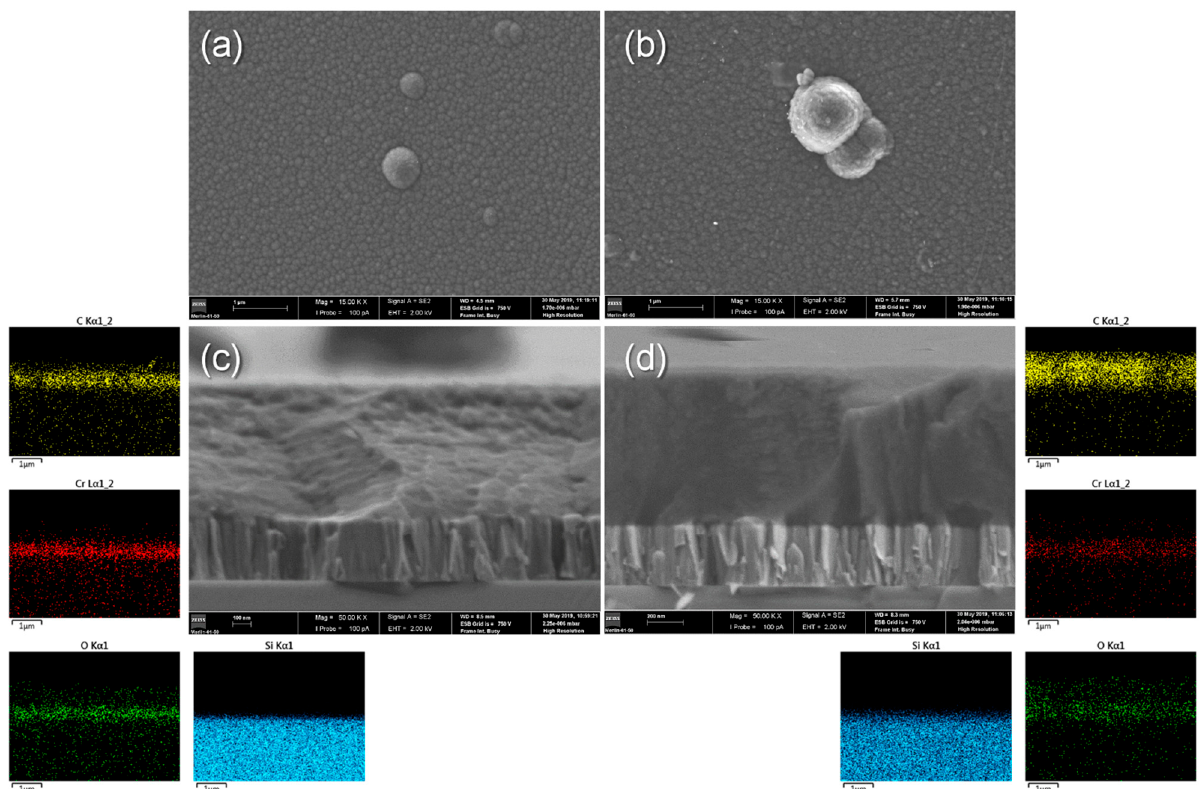
Figure 1. Surface and cross-section SEM micrographs of the as-deposited a-C:H coatings with Cr-based interlayer onto Si wafers, and the corresponding EDS elemental distribution maps: ( a , c ) for a-C:5H coatings; ( b , d ) for a-C:10H coatings.